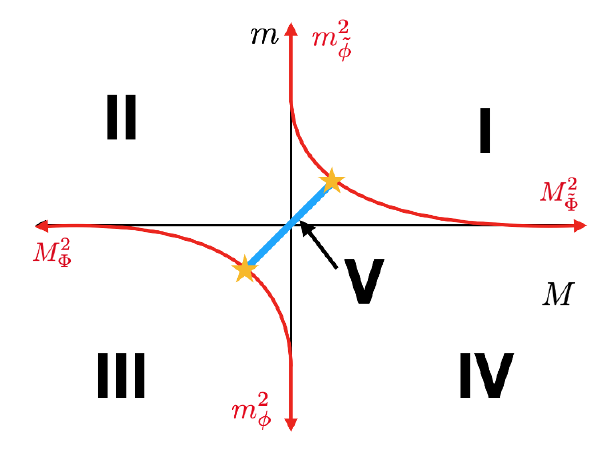
Figure 8 . Phase diagram for (cid:13)avor broken QCD 3 with f = k; F = k . These pahses are described in section 2.2.6. This symmetry breaking pattern was (cid:12)rst conjectured by Vafa and Witten